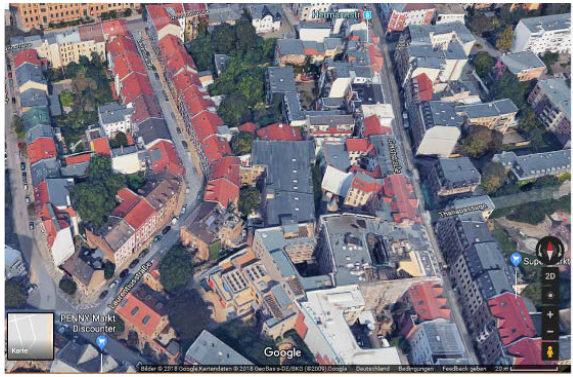
Figure A2. Example of old perimeter development/old buildings with private green space (Google Maps 2018).